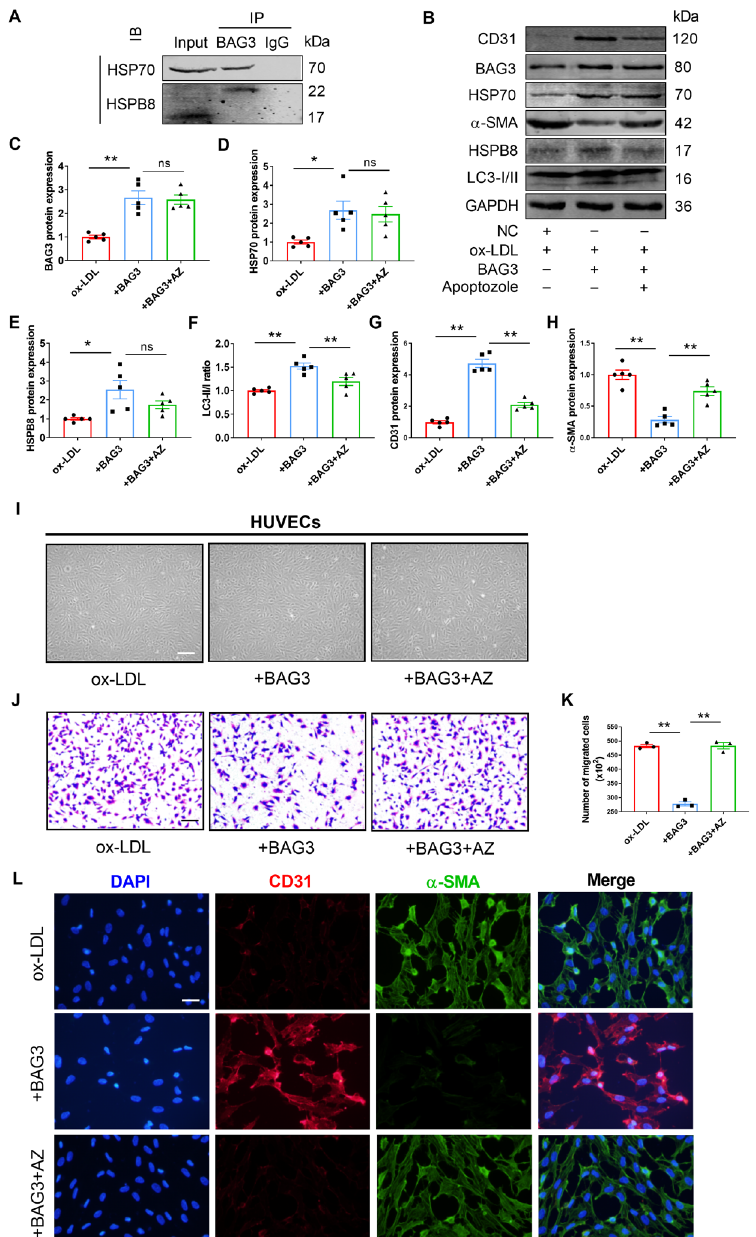
Figure 6. BAG3 blocks ox-LDL-induced EndMT through formation of CASA complex with HSP70 and HSPB8 in HUVECs. ( A ) Co-IP analysis for the interaction of BAG3 with HSP70 or HSPB8. HUVEC extracts were immunoprecipitated with anti-BAG3 antibody and probed with anti-HSP70 or anti-HSPB8 antibody. ( n = 3). ( B – H ) BAG3, HSP70, HSPB8, CD31, and α -SMA protein expressions and the LC3-II/LC3-I ratio were analyzed using Western blotting. Fold changes are shown ( n = 5). ( I ) Morphological changes post the indicated treatments were observed under a microscope (scale bar indicates 100 µm). ( J , K ) Transwell cell invasion assay was performed to analyze the migration ability of cells (scale bar indicates 100 µm). ( n = 3). ( L ) Representative images of double-fluorescent staining with α -SMA (green) and CD31 (red). The nuclei were stained blue with DAPI (scale bar indicates 50 µm). The data are presented as the mean ± S.E.M. ns p > 0.05, * p < 0.05, ** p < 0.01.